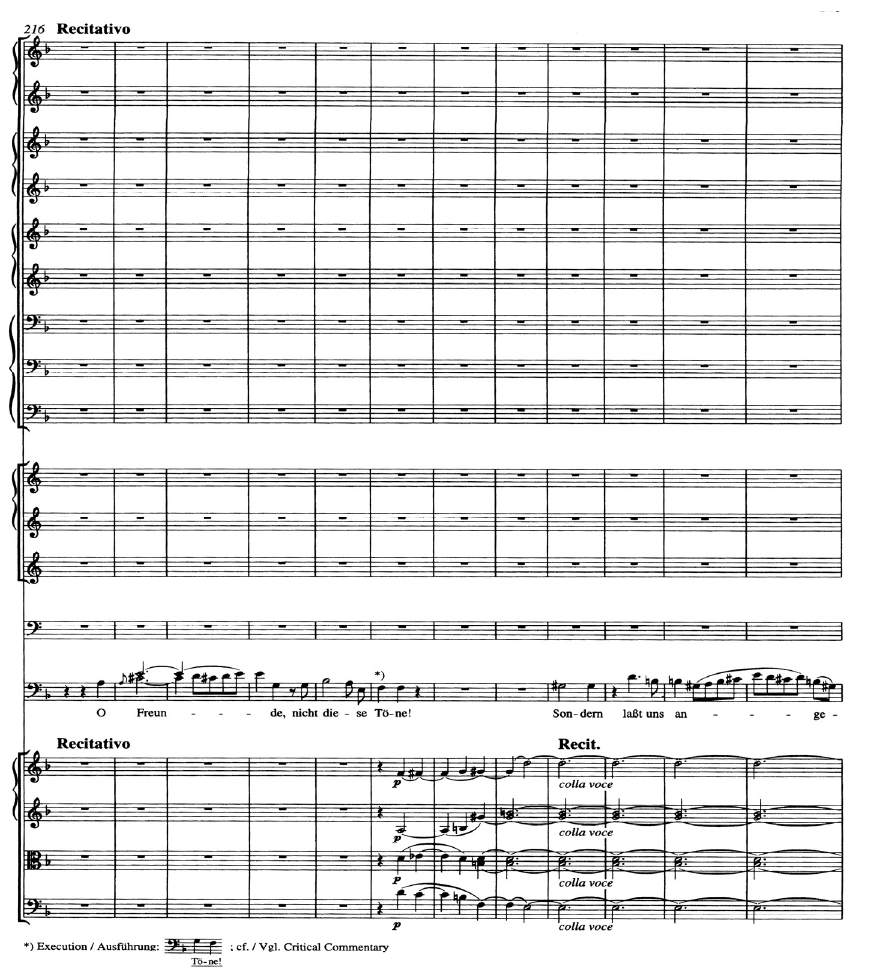
Figure 2. Ludwig van Beethoven, Symphony No. 9 in D Minor, Op. 125, Finale. Urtext edited by Jonathan Del Mar, Kassel: © 1999, Bärenreiter-Verlag. Finale, Recitativo, mm. 216–227. Used with permission of Bärenreiter-Verlag,